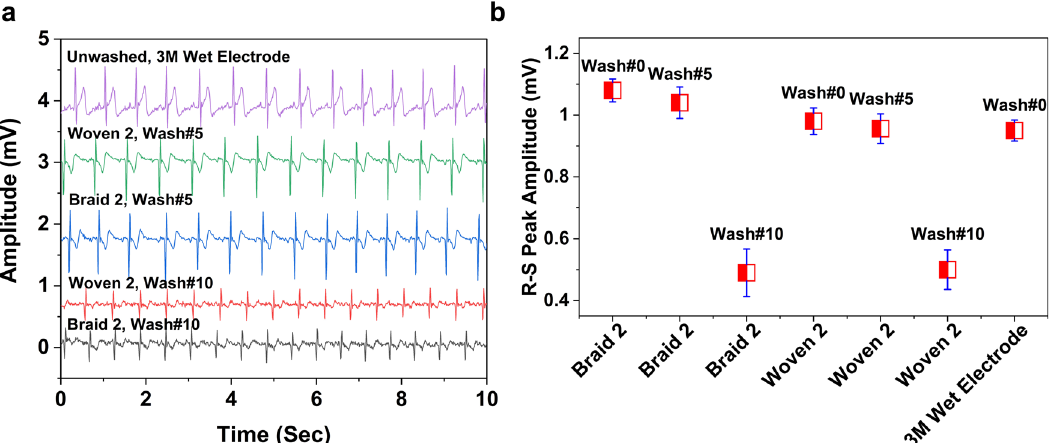
Fig. 5 Wash Durability of CNT Textile Electrodes. ECG signals after a different washing b R-S peak amplitude before and after washing. Data are presented as mean ±